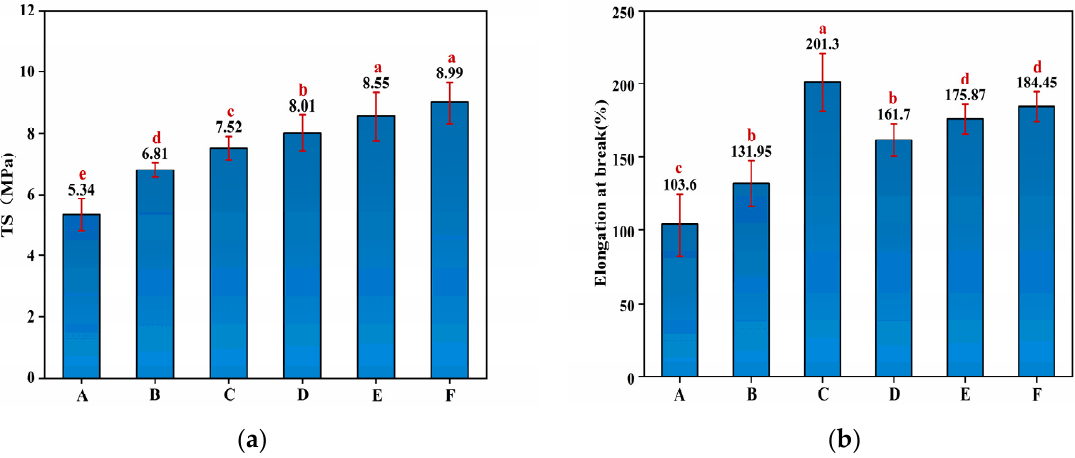
Figure 2. The mechanical properties of ( a ) TS; ( b ) EB of composite membrane samples of starch– (A) PVA; (B) HNTs/starch–PVA; (C) CNF/starch–PVA; (D) HNTs–CNF/starch–PVA; (E) HNTs–KH560–CNF starch–PVA; (F) HNTs– KH570–CNF starch–PVA.